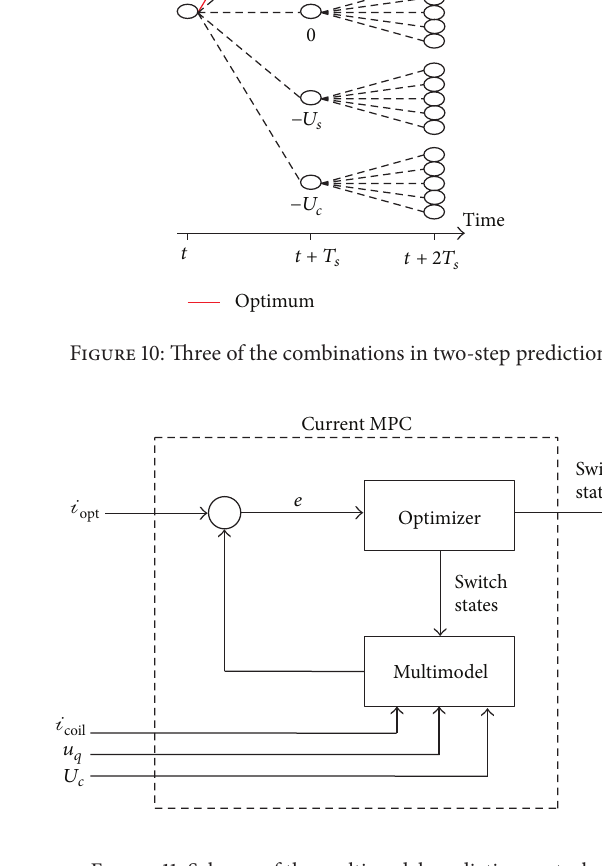
Figure 11: Scheme of the multimodel predictive